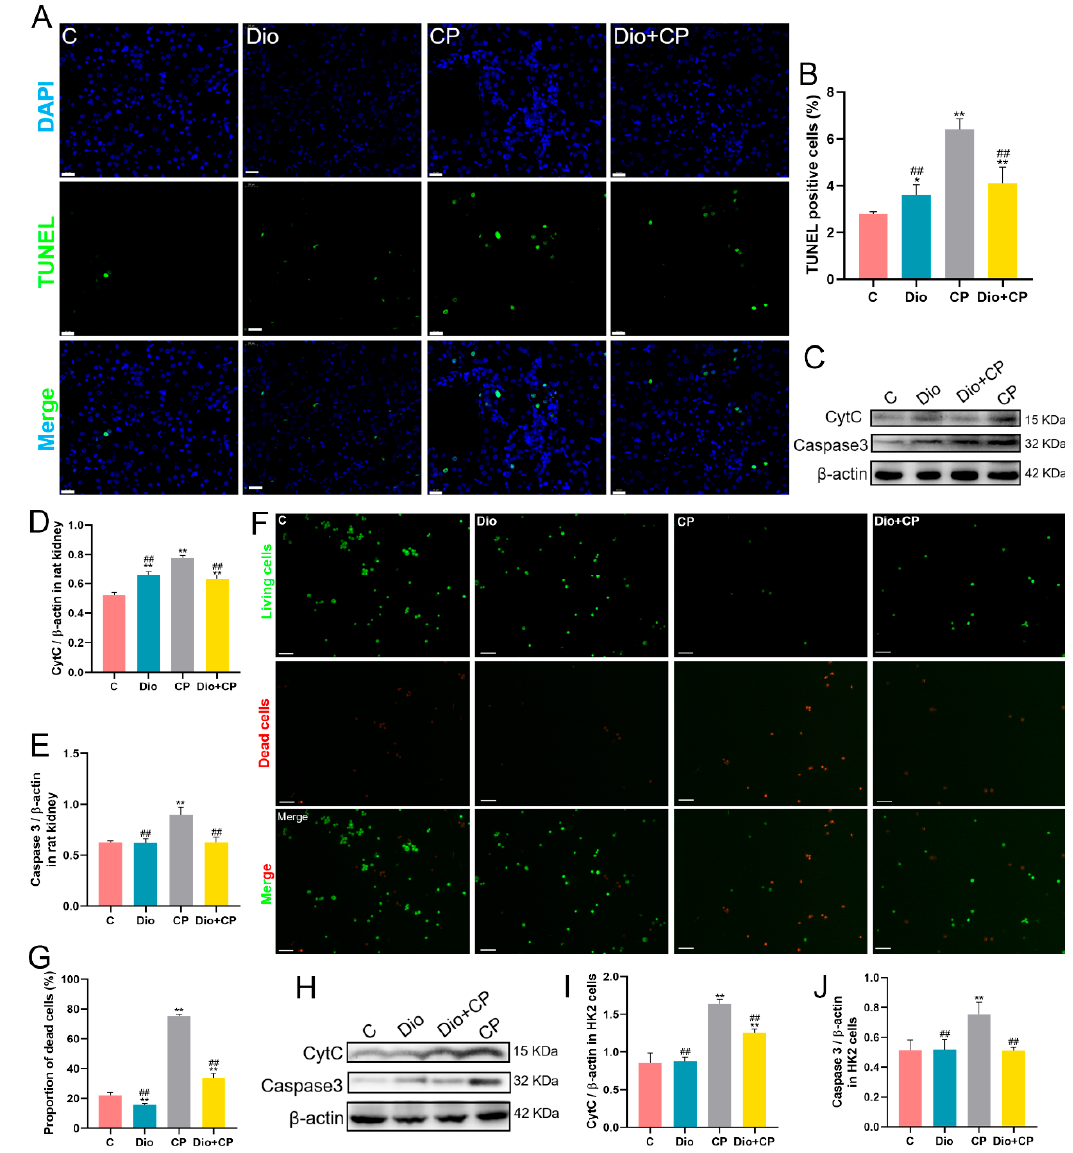
Figure 3. Dioscin reduces cisplatin-induced apoptosis in rat kidney and HK2 cells. ( A , B ) Representa- tive images and quantification of TUNEL staining (scale bar = 20 μ m) in rat kidney (n = 5). ( C – E ) The protein expression of CytC and Caspase3 in rat kidney (n = 3). ( F , G ) Representative images and quantification of AO/EB staining (scale bar = 100 μ m) in HK2 cells (n = 5). ( H – J ) The protein expression of CytC and Caspase3 in HK2 cells ( n = 3). C, control group; Dio, dioscin group; CP, cisplatin group; Dio + CP, dioscin + cisplatin group. Results are presented as Mean ± SD. Statistical signifi- cance was obtained by one-way ANOVA. * p < 0.05, ** p <0.01 compared with C group. ## p < 0.01 compared with CP group.